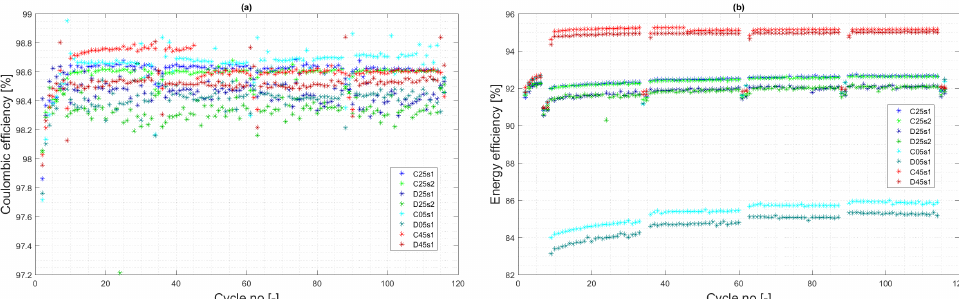
Figure 7. Measured values of Coulombic ( a ) and energy ( b ) efficiency for all the measured cycles and samples.